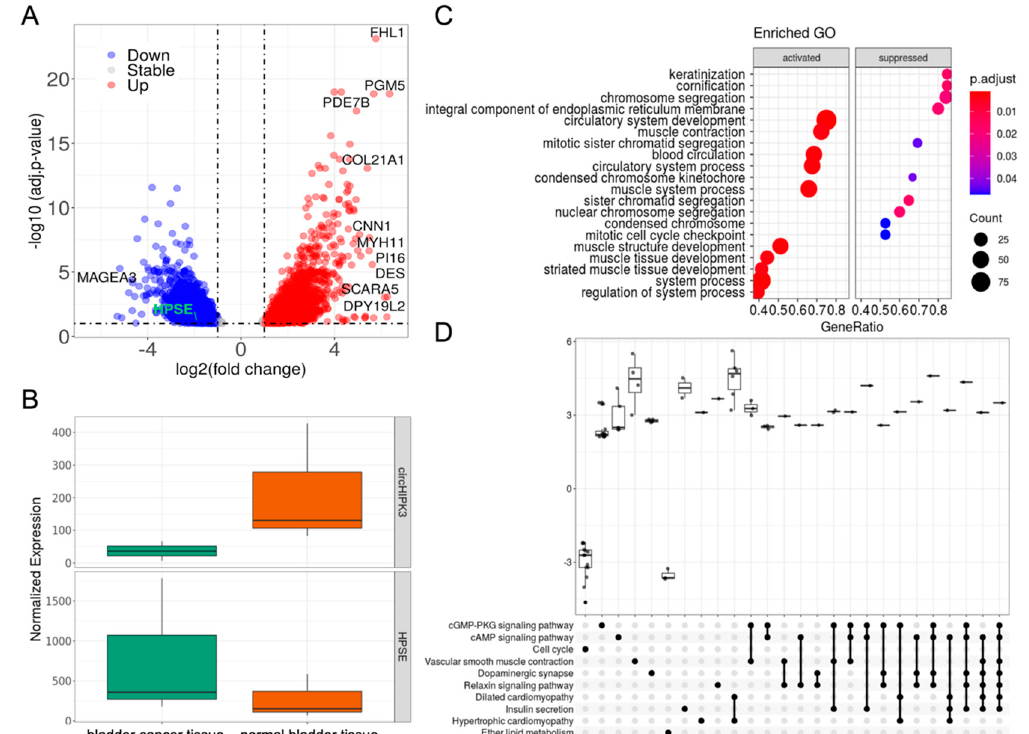
Figure 4. Putative impact of circHIPK3 in gene expression, gene ontology, and pathways. ( A ) Volcano plot of the differentially expressed genes in sample groups defined by circHIPK3 expression. ( B ) CircHIPK3 and the HPSE gene are respectively up- and downregulated in bladder cancer. ( C ) Top 10 activated and suppressed GO enriched in differentially expressed genes in the group comparisons ( D ) Pathways most enriched in deregulated genes.